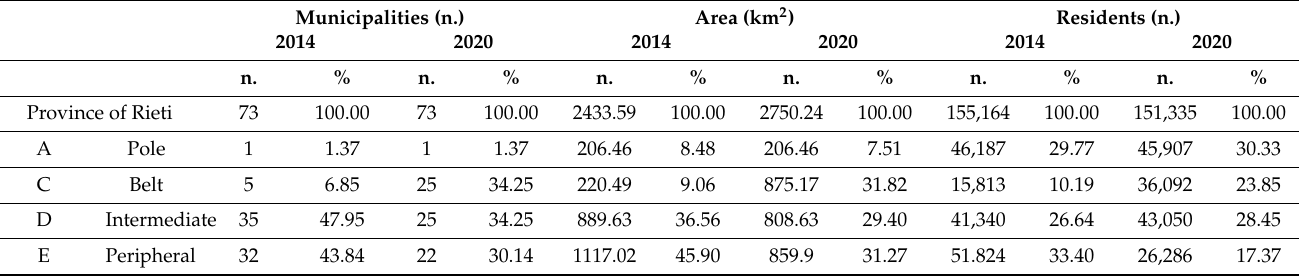
Table 1. An overview of the Province of Rieti. Author’s own table. Municipalities (n.)